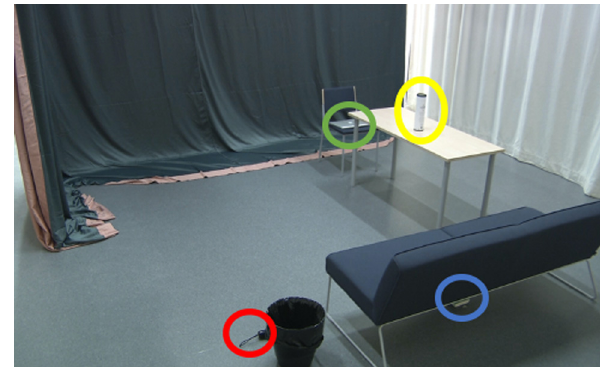
Figure 4: The room setting in the second phase of the